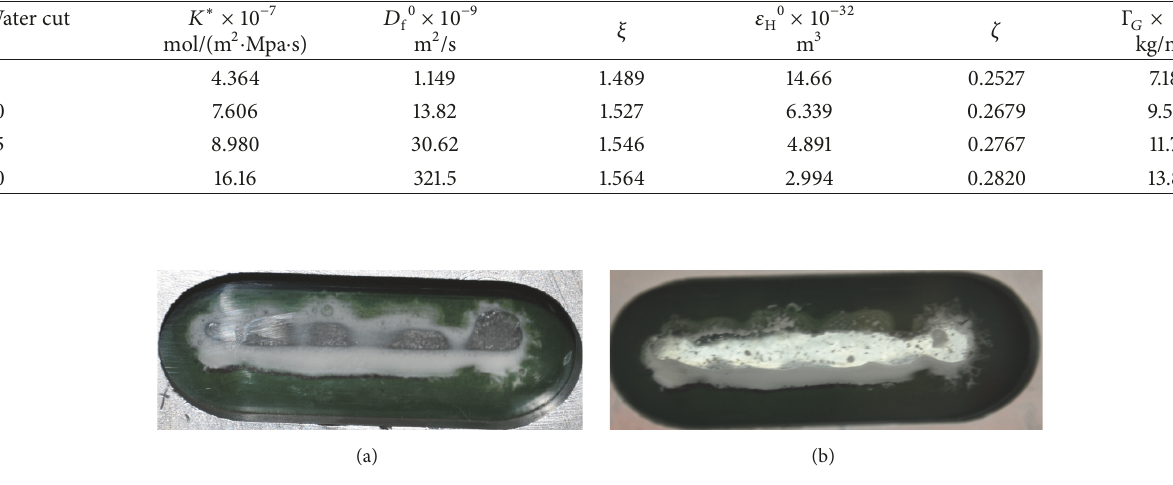
Figure 3: Photos of stratified flow: (a) stratified smooth flow and (b) stratified wave flow.